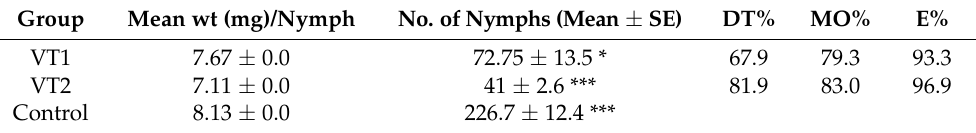
Table 6. Protective efficacy of VT1 and VT2 peptides against challenge infestations of larvae of H. anatolicum (IVRI-2 strain).